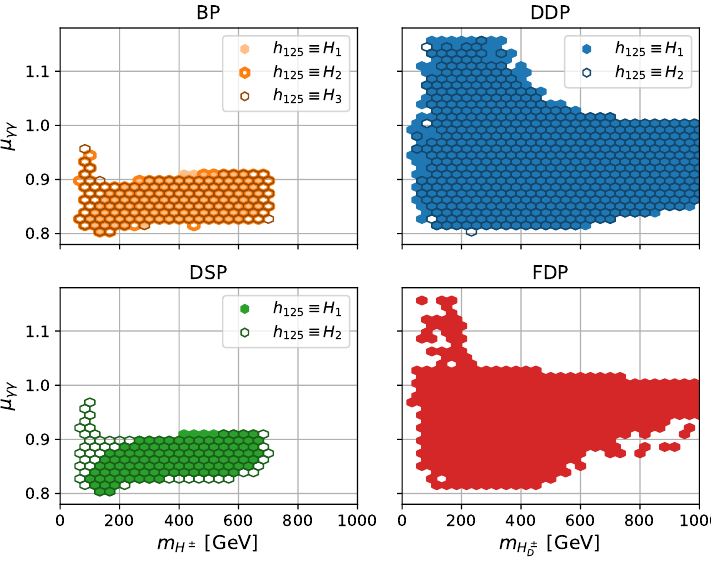
Figure 5 . (cid:22) (cid:13)(cid:13) as a function of the charged Higgs mass for the four N2HDM phases.